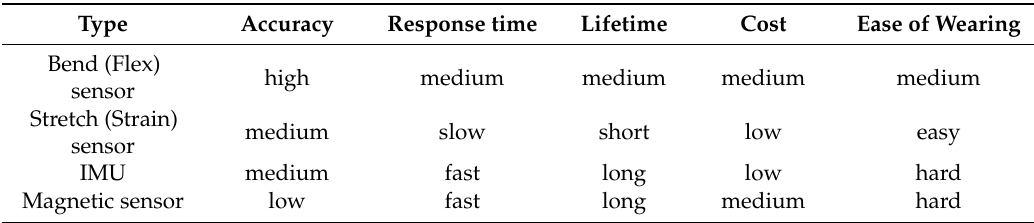
Table 1. Comparison between different types of wearable sensors.